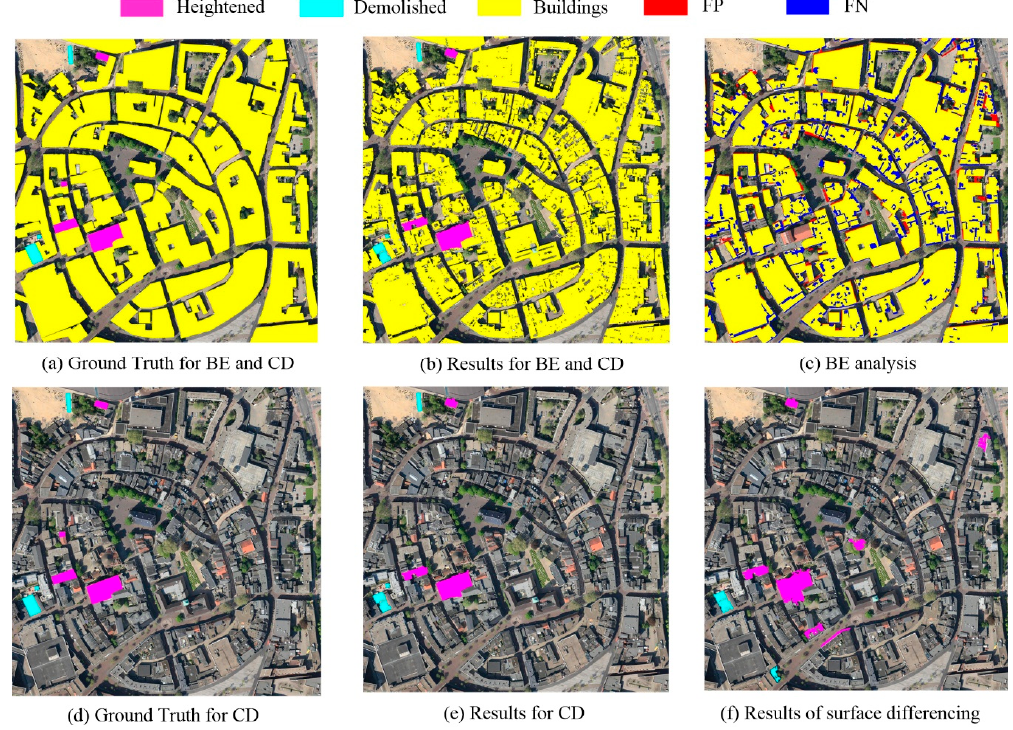
Figure 12. Experimental result of Enschede data. (BE: building extraction; CD: change